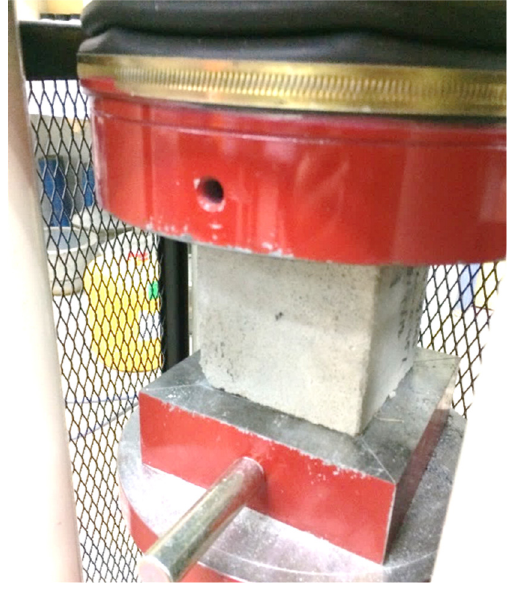
Figure 5. Setup for compression test.